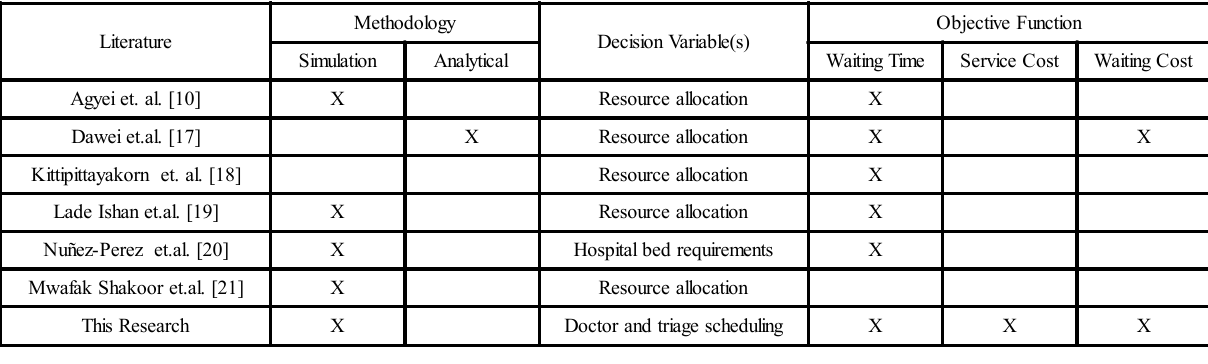
TABLE 1. SUMMARY OF